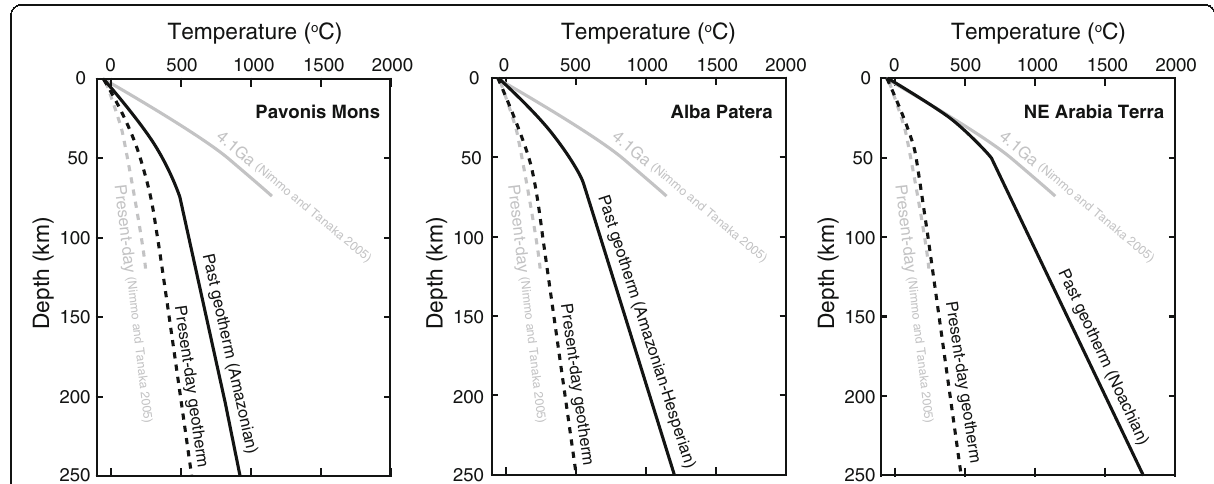
Fig. 4 Calculated thermal structure of the lithosphere at Pavonis Mons, Alba Patera, and NE Arabia Terra. The present-day thermal structure was calculated using radioactive element concentrations inferred from gamma-ray spectrometry and crustal thickness. Geotherms during the formation of each region were estimated using the half-lives of radioactive elements. The present day and 4.1 Ga geotherms of Nimmo and Tanaka (2005) are shown for